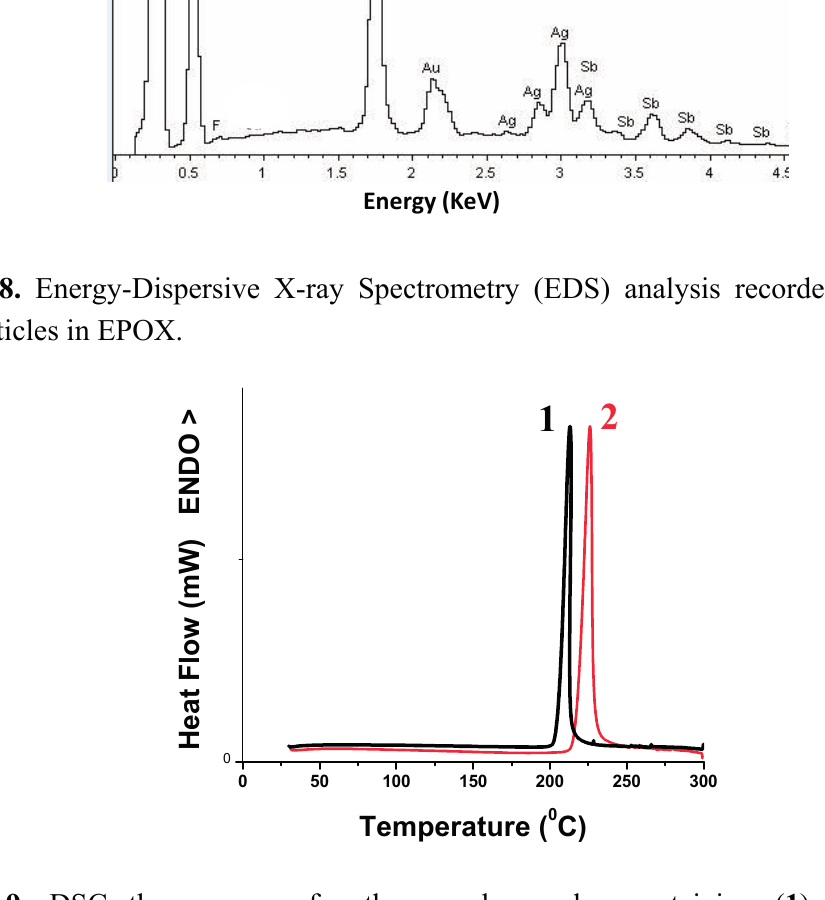
Figure 9. DSC thermograms for the cured samples containing ( 1 ) DPSi/AgSbF 6 (2%/1% w/w ) and ( 2 ) DPSi/NVK/AgSbF 6 (2%/2%/1% w/w ) in